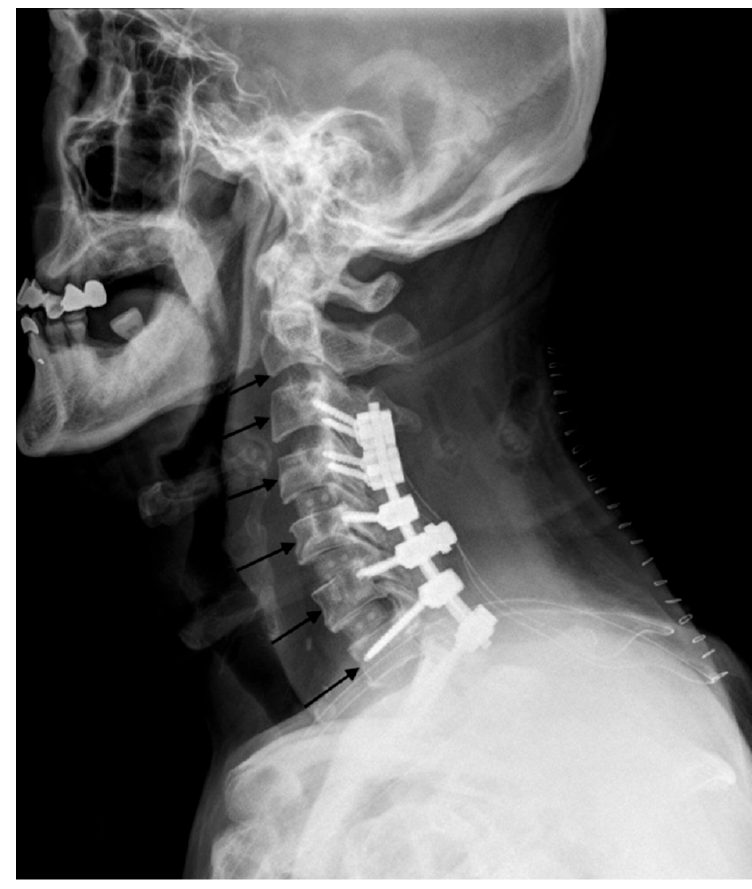
Figure 1. Plain radiograph showing PSTS measurements.